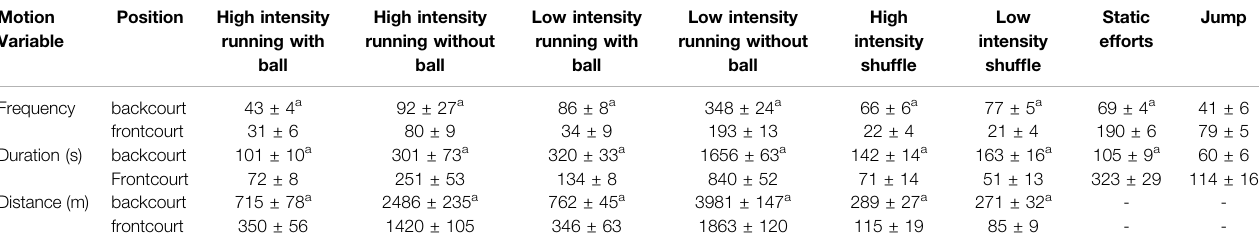
TABLE 2 | Frequency (#), duration (s), and distance (m) of the seven movement categories for the backcourt ( N (cid:1) 42) and frontcourt ( N (cid:1) 28) players during elite male basketball games analyzed by video-based time motion analysis (mean ± SD). Motion Variable